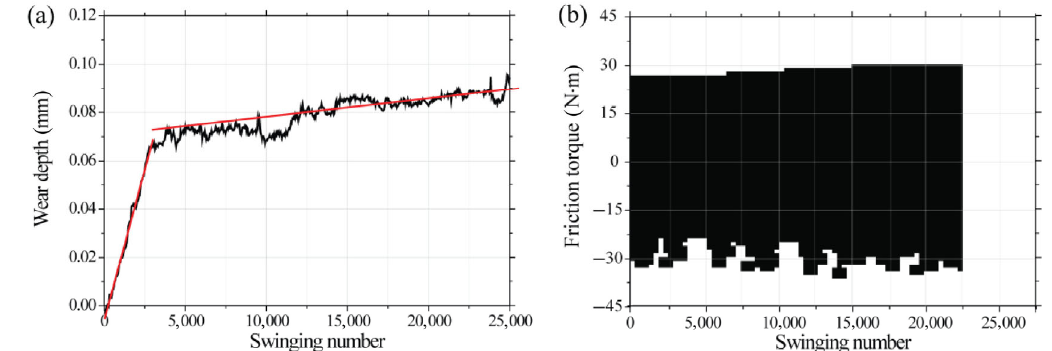
Fig. 11 Variation curves of the wear depth and friction torque with swing numbers: (a) wear depth and (b) friction